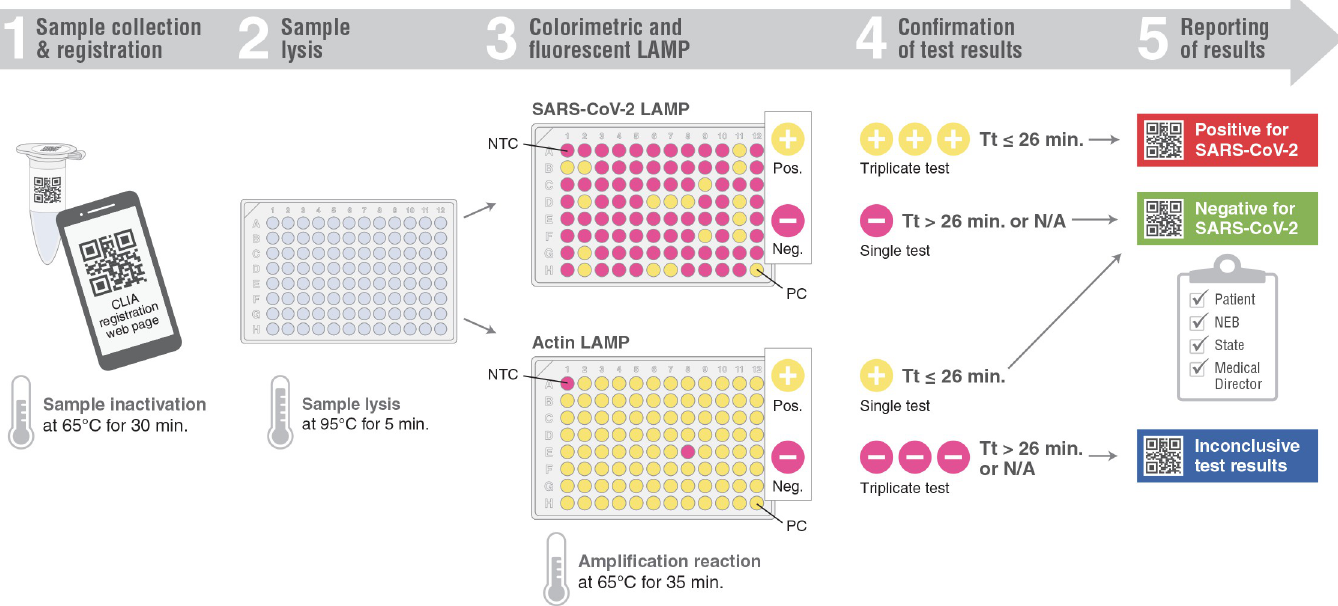
week from April to July 2021, and from August 2021 to February 2022, the frequency was increased to twice per week. A total of 755 individuals (registered as 406 males, 341 females,